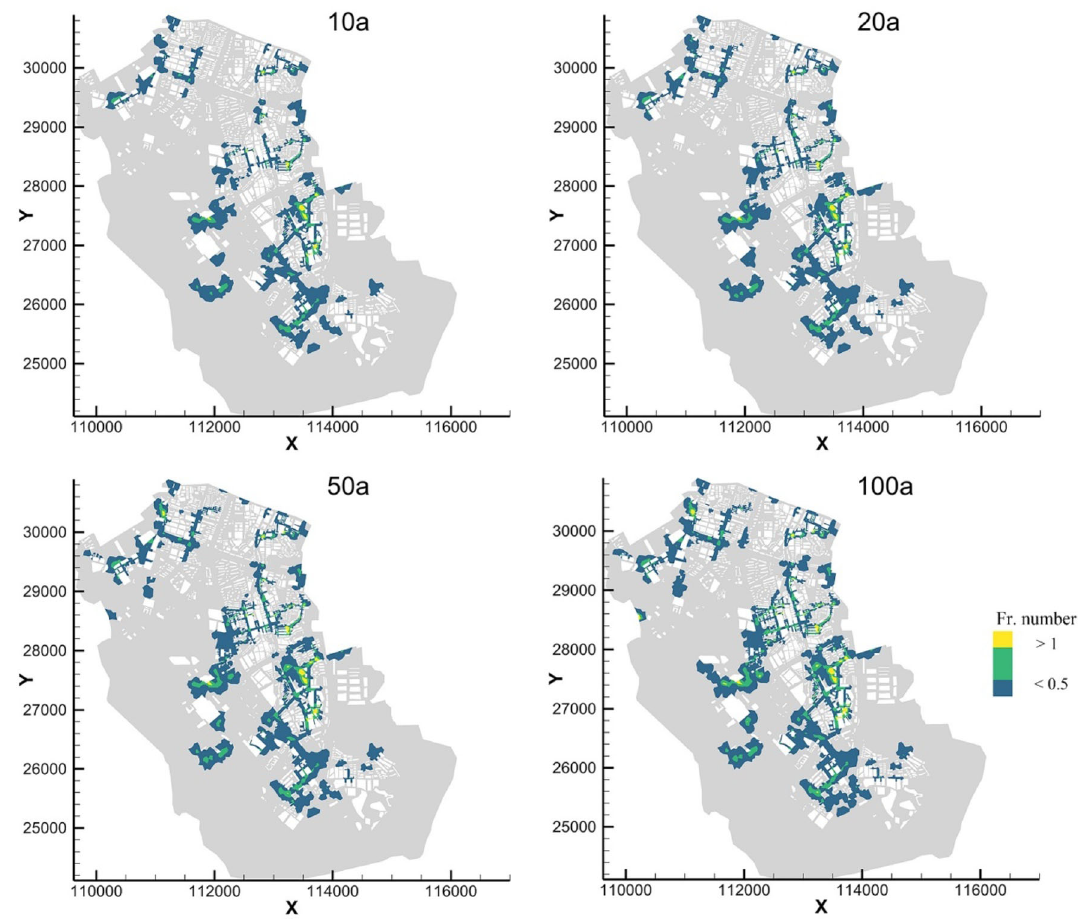
Fig. 15 Distribution of the maximum Froude number in the four return periods (10a, 20a, 50a, and 100a) Table 5 Information on the supercritical flow cells and wet cells Number of